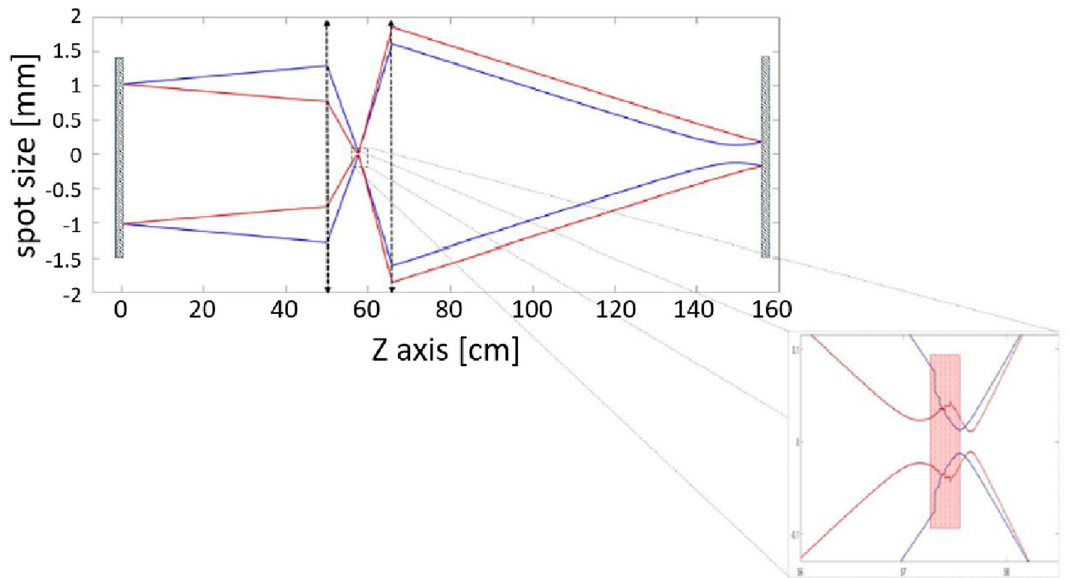
Figure 2. Symmetry-breaking between the forward and backwards halves of the cavity round trip (simulation): The oscillator breaks the propagation symmetry in order to employ higher pulse power and energy. The figure shows the numerically simulated beam width during the entire round-trip in the cavity, where the forward half (blue) is different from the backwards half (red), exhibiting different focusing power through each. Inset: zoom-in on the beam profile within the nonlinear Kerr